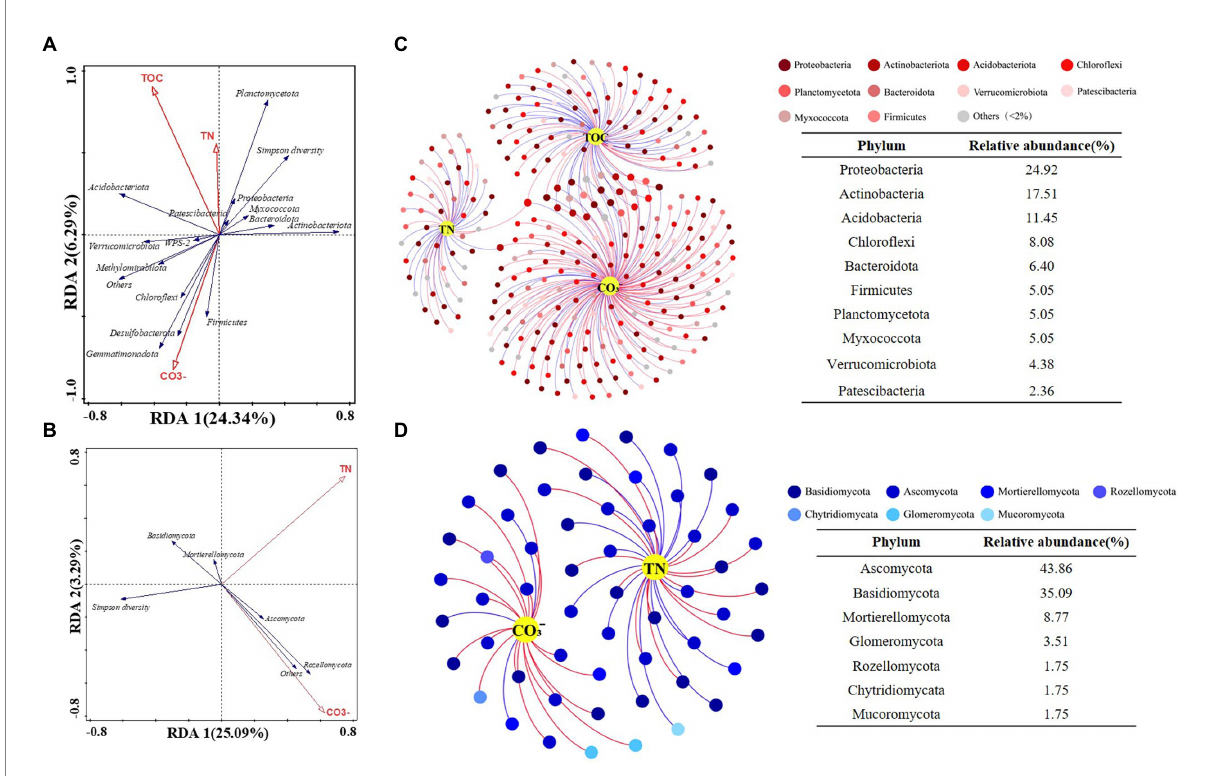
FIGURE 5 Ordination plots of the results from the redundancy analysis (RDA) to identify the relationships among the (A) bacterial and (B) fungal taxa (Blue arrows) with the soil physiochemical characteristics (Red arrows). Co-occurrence network visualize the interactions of (C) bacterial and (D) fungal communities with key environmental factors. Points represent nodes (species) and edges represent significant correlations ( p < 0.05, |r| < 0.6). Red lines colors represent positive correlations; blue lines colors represent negative